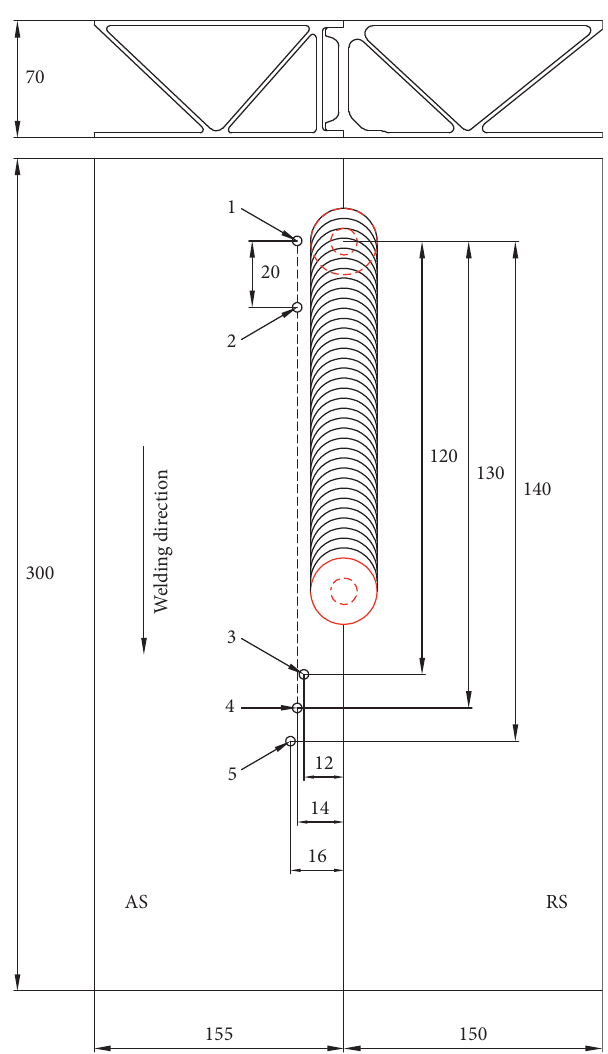
Figure 3: Dimensions of the workpiece and locations of the thermocouples. (Unit: mm).